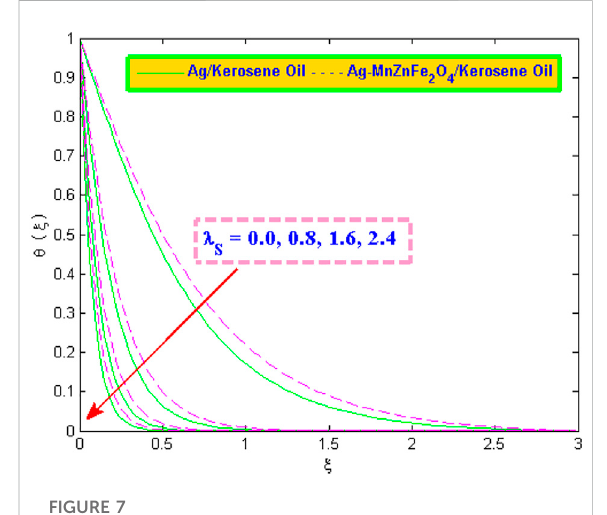
FIGURE 9 Variation in concentration with C R .